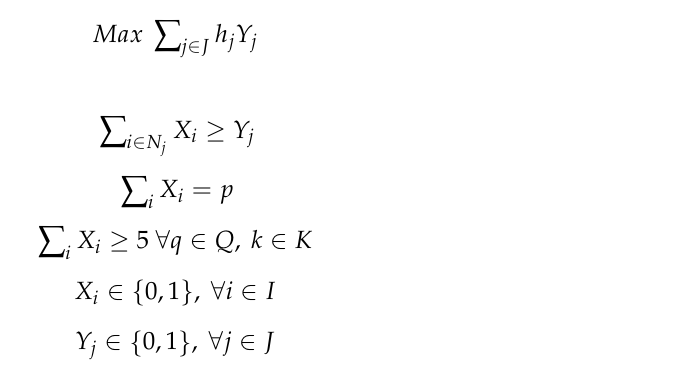
Figure 4. Histogram for each of nine variables using the 90 sites selected in the optimization process (x-axis: standardized variable value; y-axis: count).